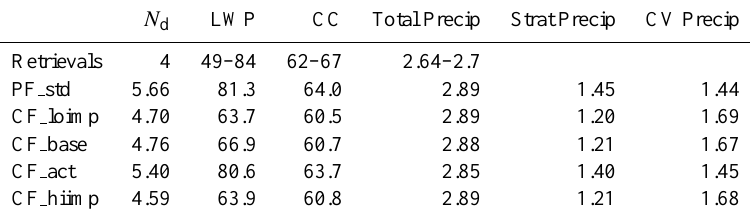
Table 4. Global and annual mean stratiform vertically integrated cloud droplet number concentration (N d ) (10 10 m − 2 ), liquid water path (LWP) (kgm − 2 ), cloud cover (CC), and precipitation (total, stratiform, and convective). LWP retrievals are from SSM/I (Greenwald et al., 1993; Weng and Grody, 1994; Ferraro et al., 1996). Total cloud cover is from ISCCP (Rossow and Schiffer, 1999) and total precipitation is from the Global Precipitation DataSet (Adler et al., 2003). Retrievals of N d are from ISCCP (Han et al., 1998). The five simulations are described in Table 1. N d LWP CC Total Precip Strat Precip CV